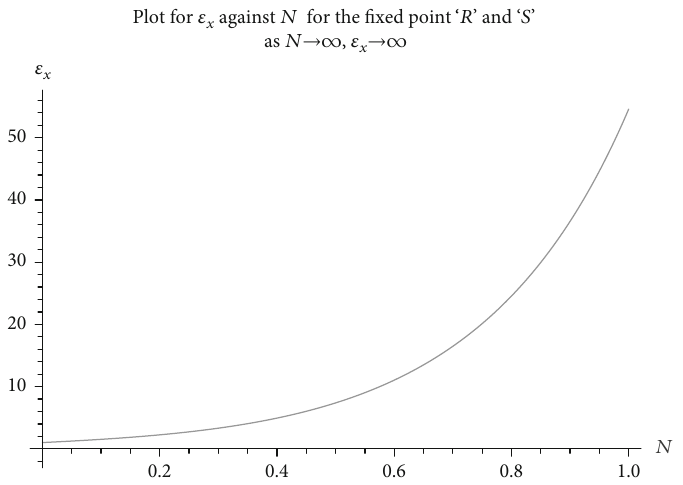
Figure 8: Shows the variation of perturbations along the x -axis ( ϵ